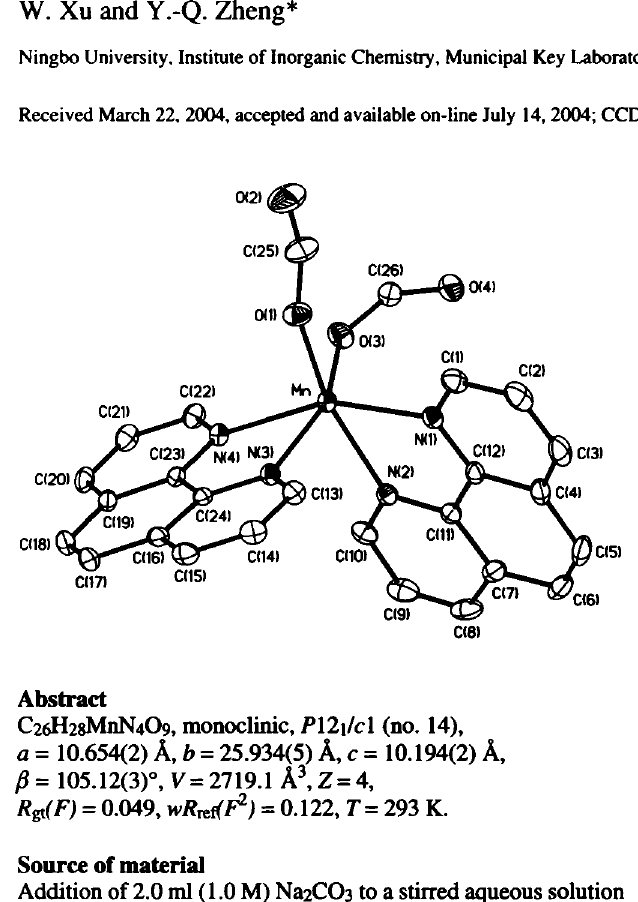
Table 1. Data collection and handling.